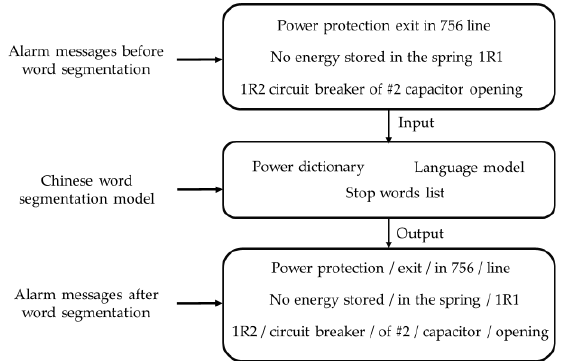
Figure 1. Block diagram of pre-processing for monitoring alarm messages.